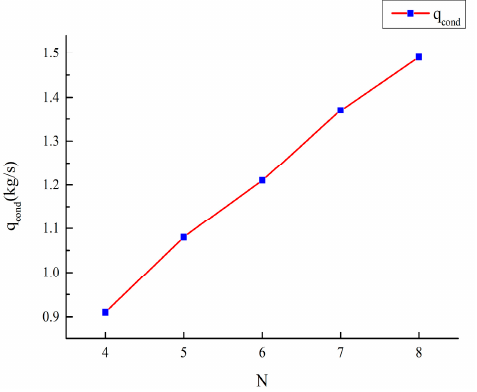
Figure 9. The amount of condensed water at di ff erent N values.